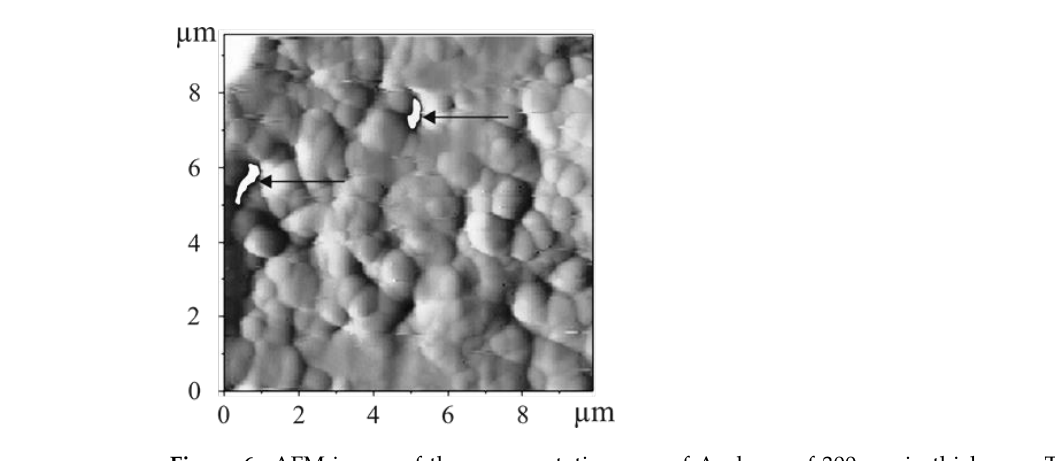
Figure 6. AFM image of the representative area of Au layer of 300 nm in thickness. The image processing code was used to select two pores, the depth of which exceeded the thickness of the layer (these pores are shown by arrows). Table 2. Physical – morphology characteristics of the coating layers.